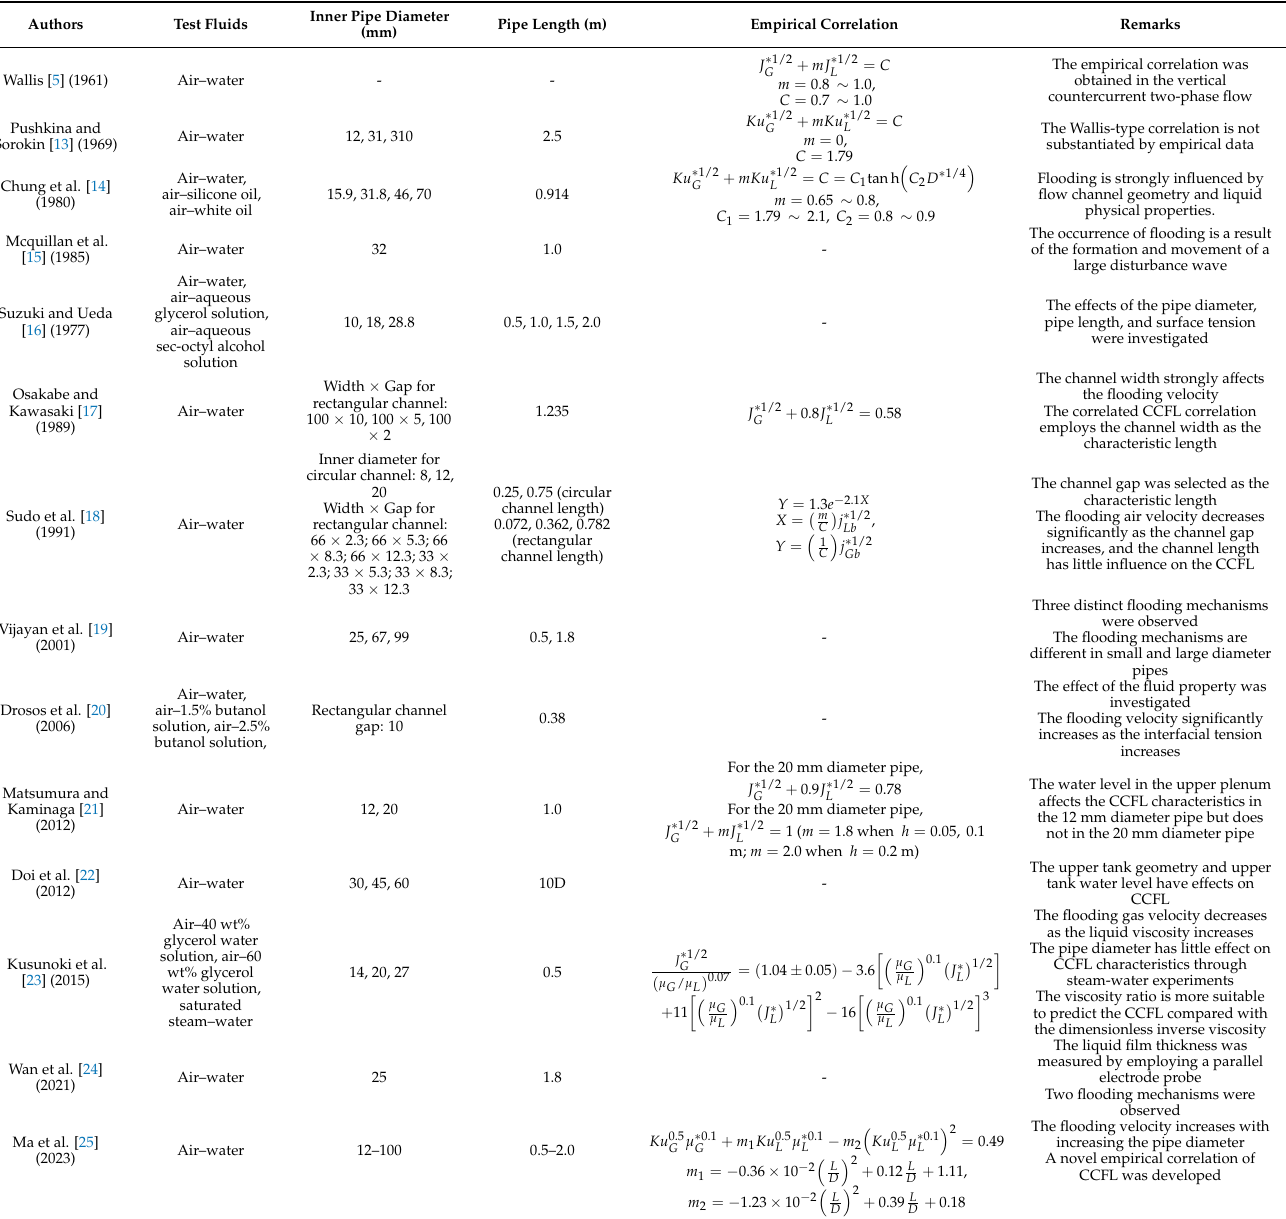
Table 1. Summary of the experimental investigations on the CCFL in vertical